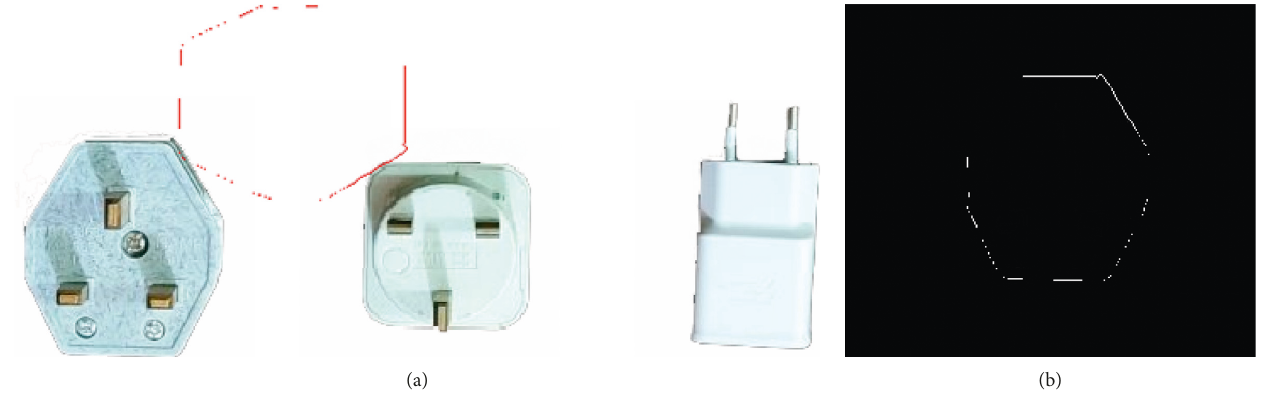
Figure 12: The matching of Sobel edge method: (a) product image captured; (b) template image.